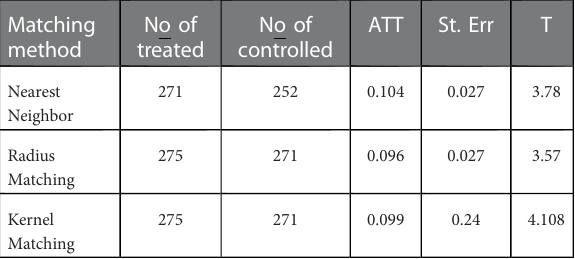
TABLE 3 Impact of utilizing the maternity waiting homes on birth outcomes among respondents on maternal waiting home utilization, east gojjam, 2017.